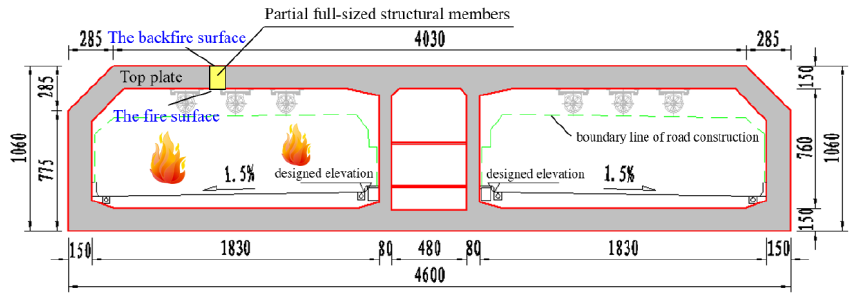
Figure 1. Cross section of the steel – concrete – steel immersed tube tunnel (unit: cm).